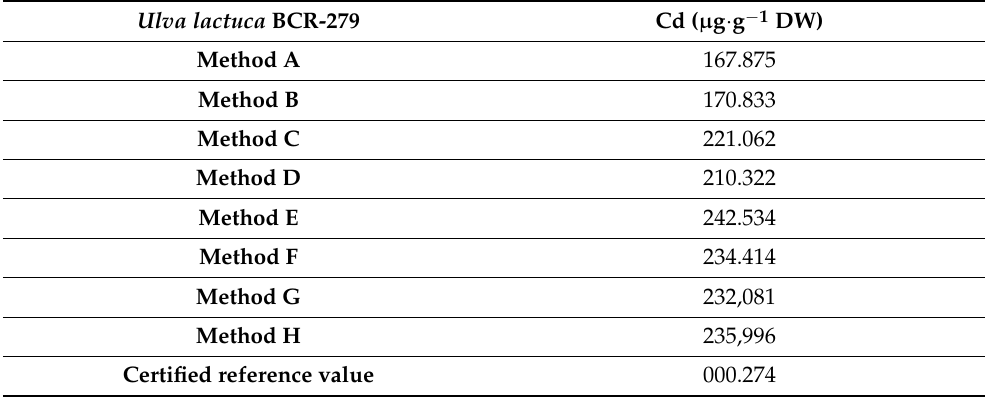
Table 4. Comparison of results obtained using tested digestion methods with certified reference values in ulva lactuca BCR-279.